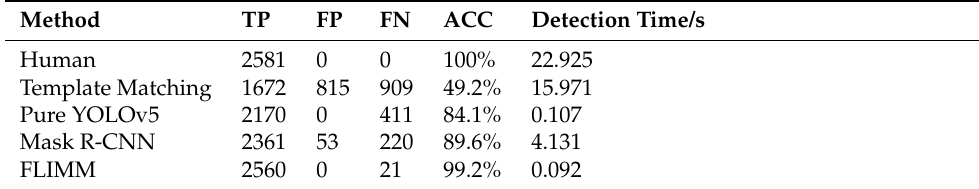
Table 2. Comparison of the results of different methods for the test dataset.